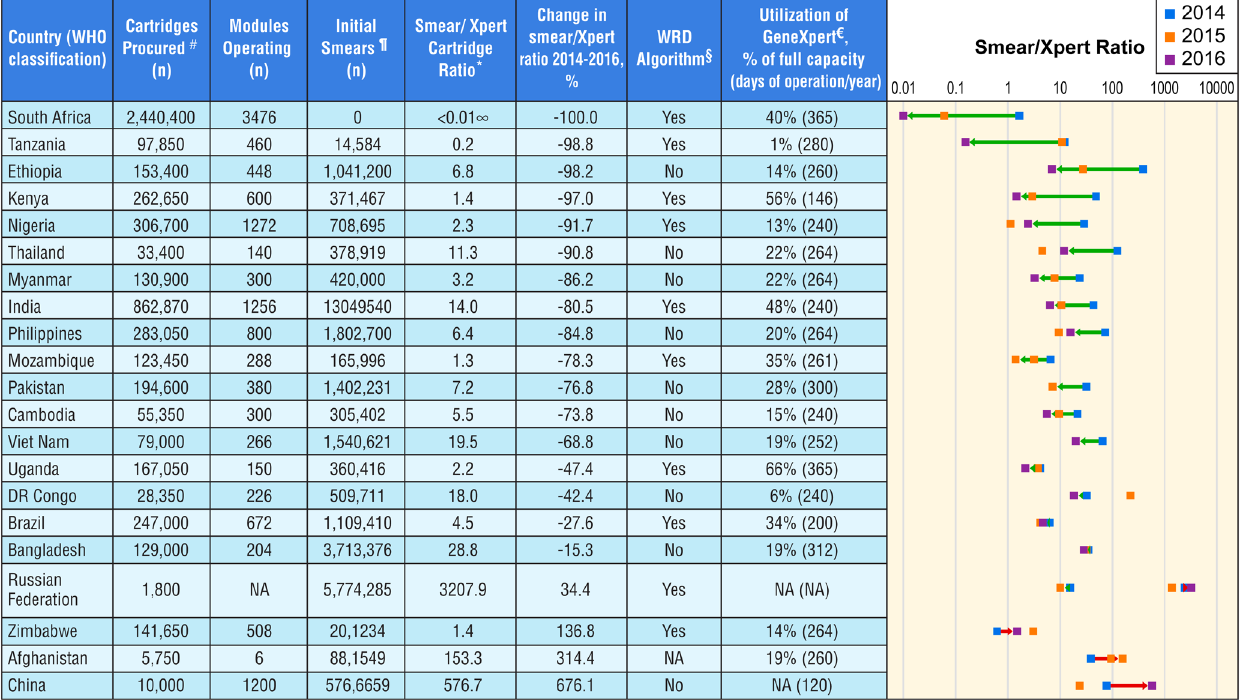
between 51–100 and three (14%) countries had a ratio